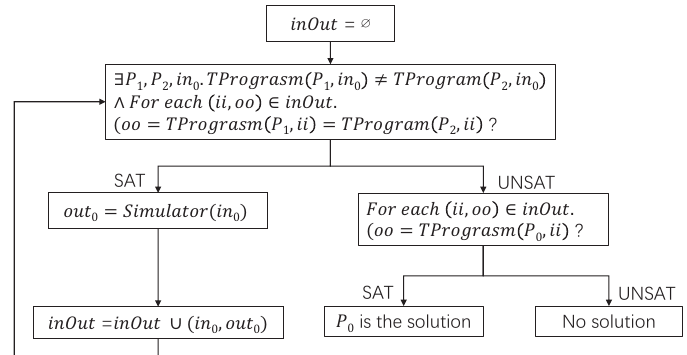
Figure 3. The algorithm used in our